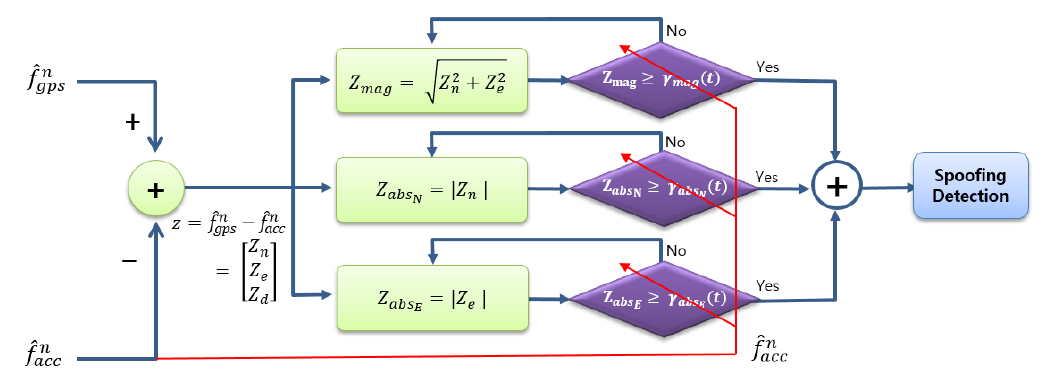
Figure 2. The Structure of the Second-half of the proposed direct GPS spoofing detection after Figure 1.